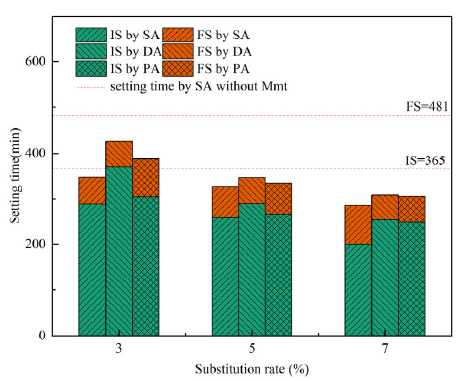
Figure 4. Initial setting (IS) and final setting (FS) time of cement pastes with PCE and PR under different substitution rate of Na-Mmt.